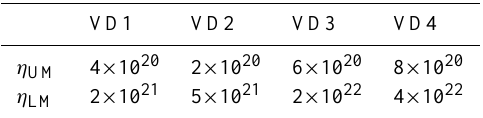
Table 1. Upper and lower mantle viscosity values (Pa s) for the four applied viscosity distributions.